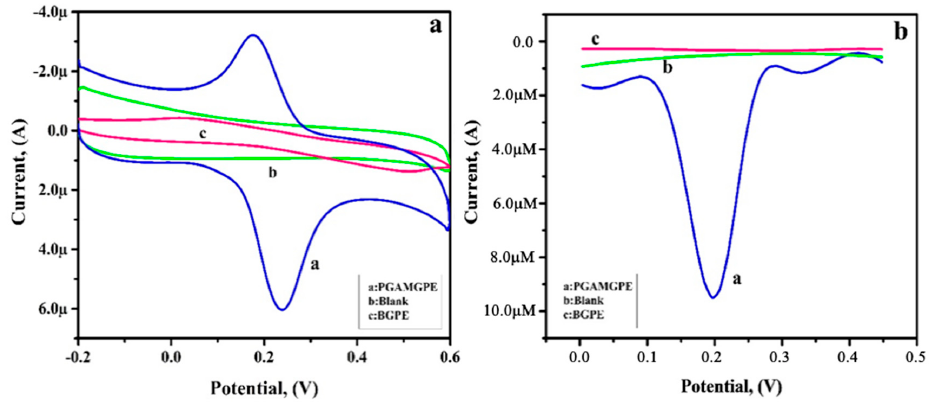
Figure 7. ( a ) CV response of 0.1 mM RU at PGAMGPE (curve a), BGPE (curve c), and blank (curve b) with the scan rate of 0.10 V/s. ( b ) DPVs for 0.1 mM RU on PGAMGPE (curve a), at BGPE (curve c), and blank (curve b).